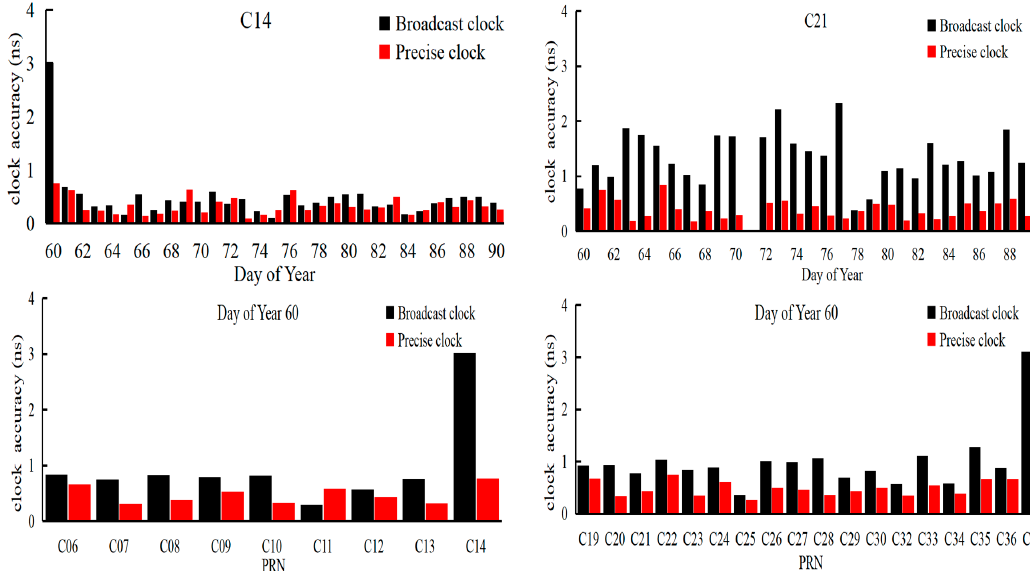
Figure 11. The daily clock offset accuracy of various satellites resulting from Scenario 1 (black) and Scenario 2 (red) and the B1I and B3I observations during the 31 day period (upper panels) and on DOY 60 (bottom panels). Table 5. The average daily accuracy of the BDS rapid clock offsets resulting from the two types of clocks and the corresponding improvement.